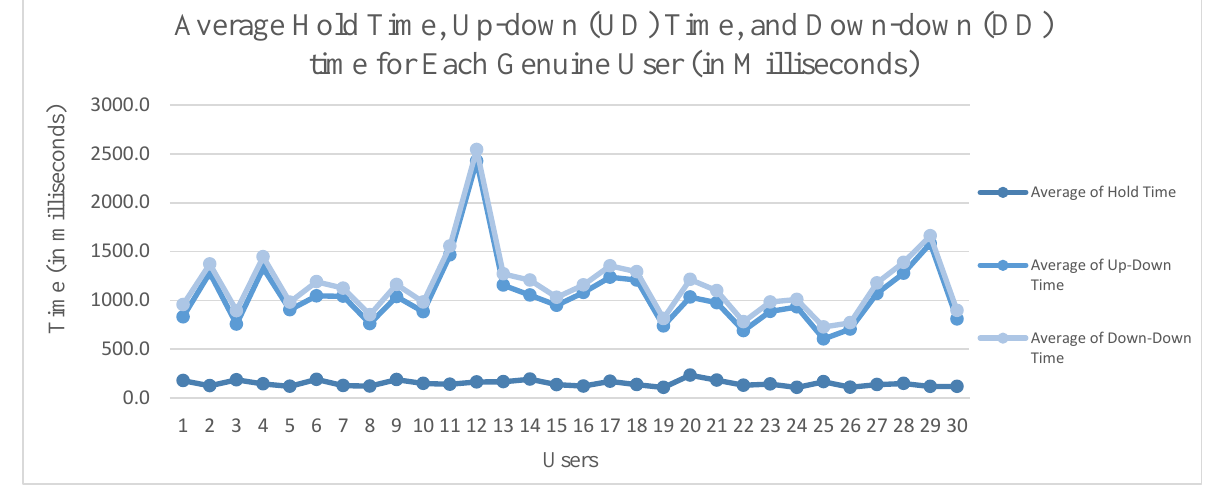
Figure 10. Average hold time, UD time, and DD time for each genuine user .